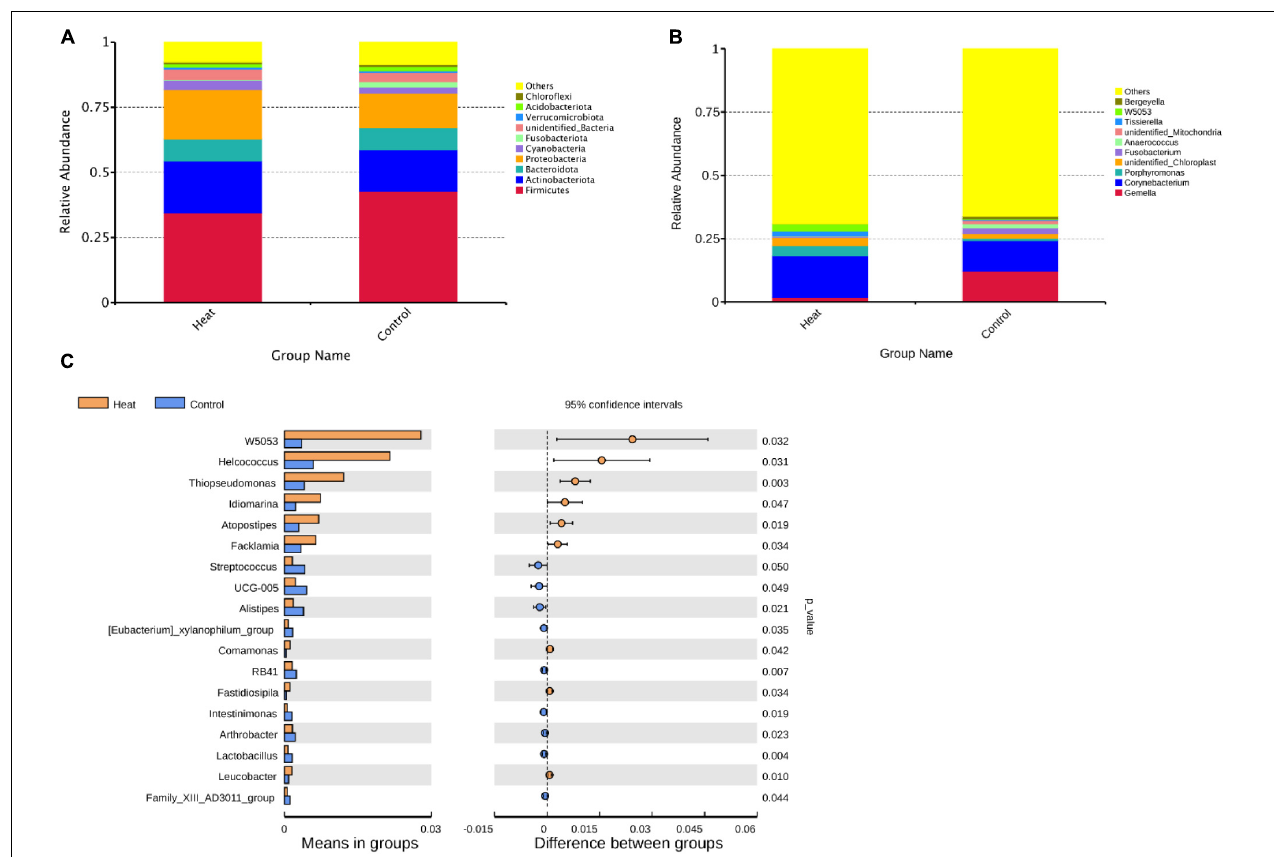
FIGURE 3 | The effects of heat stress on vaginal microbial composition of rabbit. (A) The average relative abundance of the top 10 abundant vaginal microbiota at the phylum level. (B) The average relative abundance of the top 10 abundant vaginal microbiota at the genus level. “Others” represents the proportion of microbiota unannotated or with low abundance at the phylum and genus levels, respectively. (C) Genera with significant difference in relative abundance between Heat and Control groups. p -value < 0.05 indicates that the relative abundance microbiota differ significantly between the Heat and Control